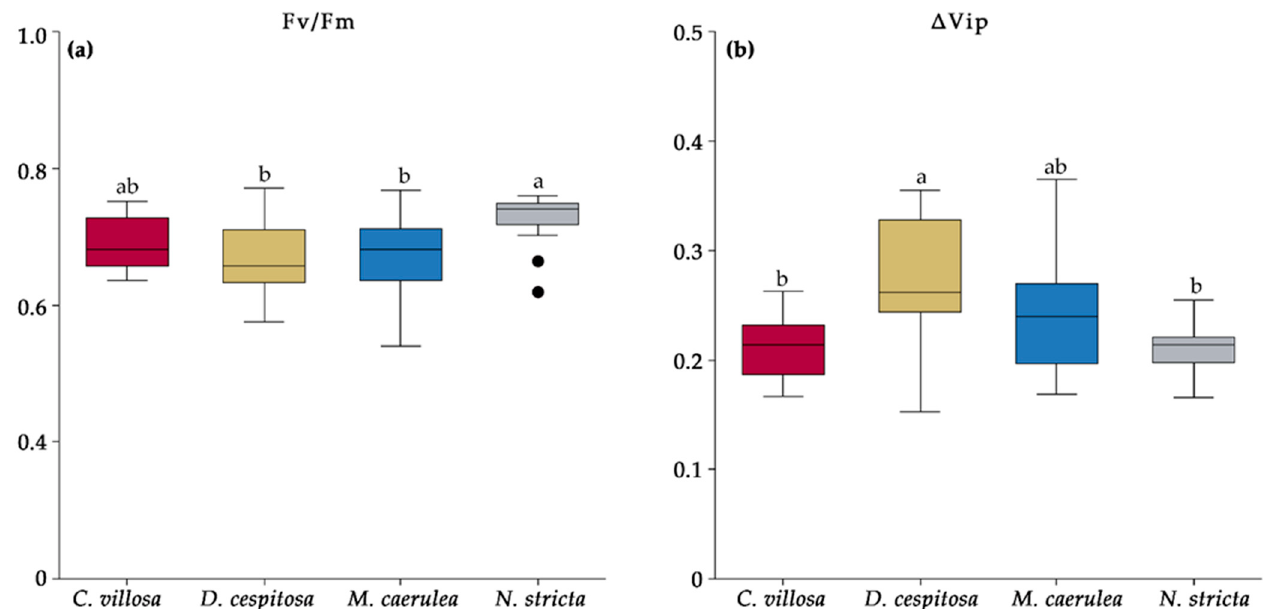
Figure 10. The chlorophyll fluorescence parameters Fv/Fm ( a ) and Δ Vip ( b ) measured in the four competing grass species from this study— Calamagrostis villosa (red boxes), Deschampsia cespitosa (yellow boxes), Molinia caerulea (blue boxes), and Nardus stricta (grey boxes)—as measured in 2020 and averaged over the growing season; n = 18 (i.e., 6 measurements per species per month—June, July, and August). Medians (central line); 25 and 75 percentiles (boxes); 1.5 interquartile range (error bars); and outliers (dots) are indicated. Different letters denote significance α = 0.05 (one-way ANOVA and Tukey–Kramer post-hoc test).